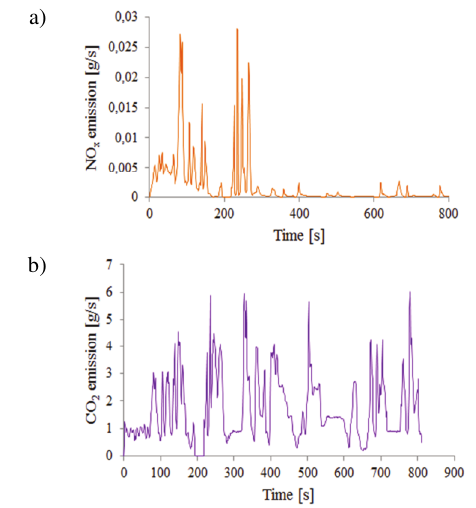
Fig. 9. Measured compounds emission per second: a) NO x , b) CO 2